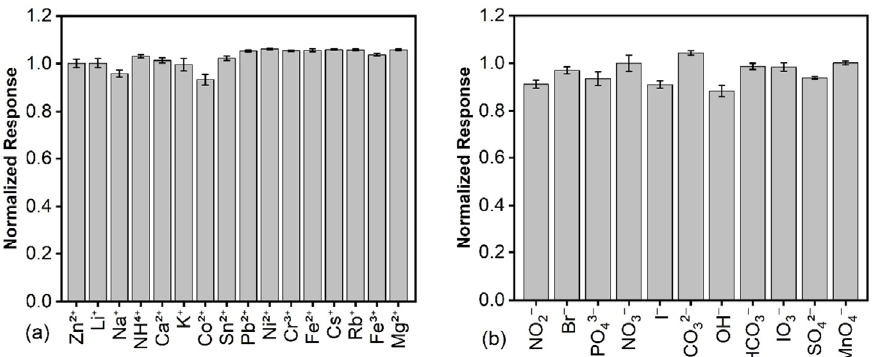
Figure 7. Fluorescence response of mixed-ligand fluorescent carbon dots to different ( a ) cations and ( b ) anions mixed with Cr(VI) at an excitation wavelength of 330 nm.